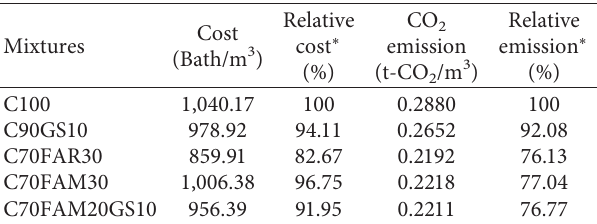
Figure 6: Weight change of specimens, in sulfuric acid solution with a pH of 1 for 240 days. (a) W/B of 0.25. (b) W/B of 0.40. Table 9: Cost-effectiveness and mitigation of carbon dioxide emission of each mix